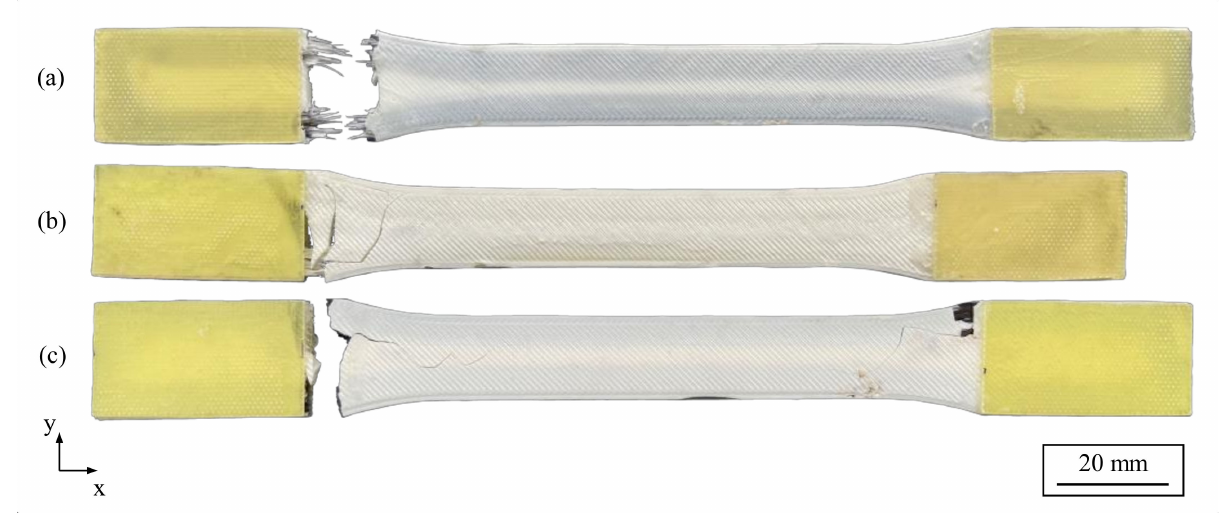
Figure 10. Examples of fractured tensile specimens: ( a ) with hybrid fiber reinforcement, ( b ) with glass fiber reinforcement, and ( c ) with carbon fiber